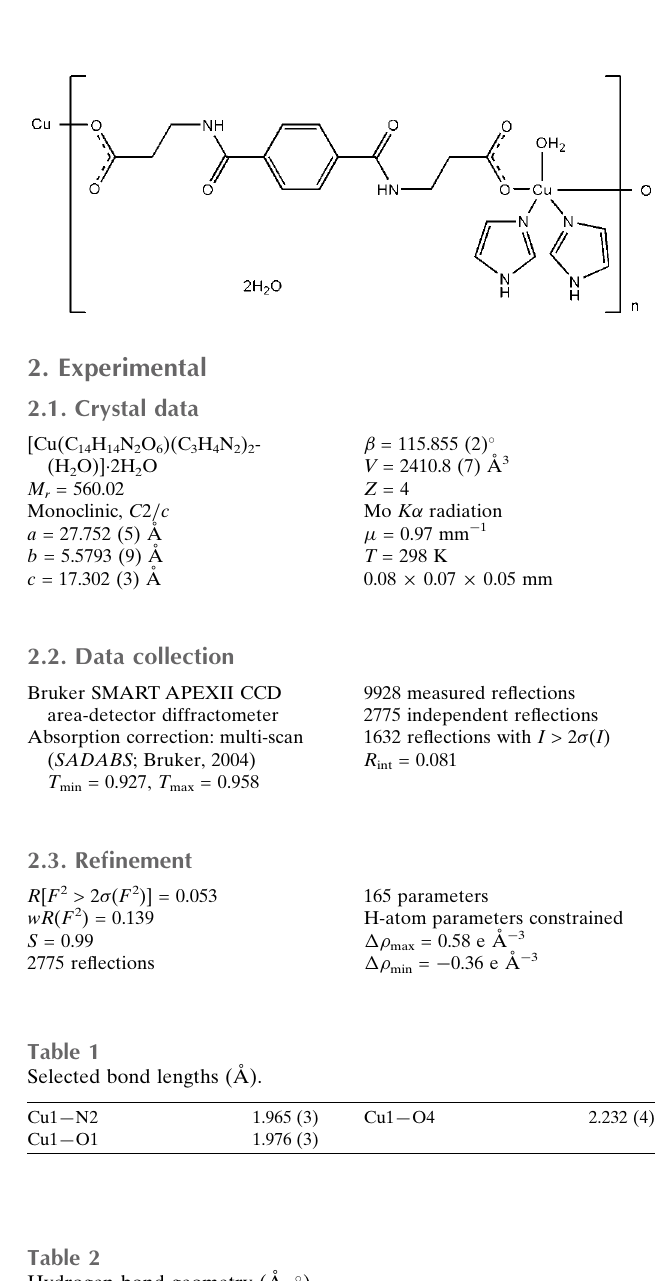
Hydrogen-bond geometry (A˚ , (cid:4)